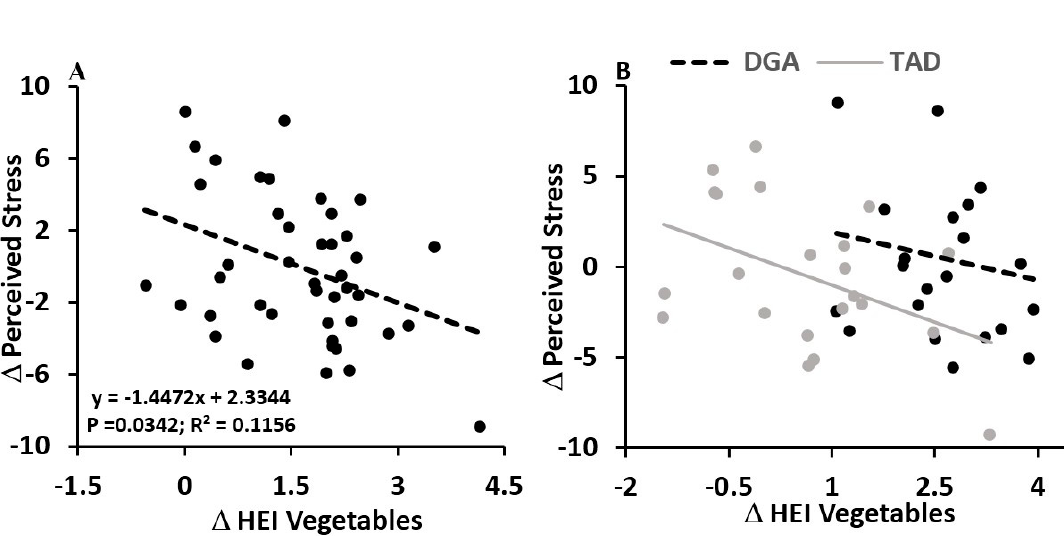
Figure 2. Independent of diet group, increasing the healthy eating index (HEI) for sodium consumption associated with reductions in the 8 week allostatic load ( A ). In the right hand figure ( B ), data and regression lines are presented for each diet group (DGA vs. TAD), showing that, for a given magnitude of delta HEI sodium, the DGA group had a higher magnitude of allostatic load change. No statistical interaction between diet group and change in HEI sodium was observed ( p = 0.7909), suggesting that regression slopes between DGA and TAD groups were not different, with both demonstrating an inverse association between delta HEI sodium and delta allostatic load. Data and regression lines presented in A and B were statistically adjusted for age, education, BMI, and pre- intervention allostatic load.